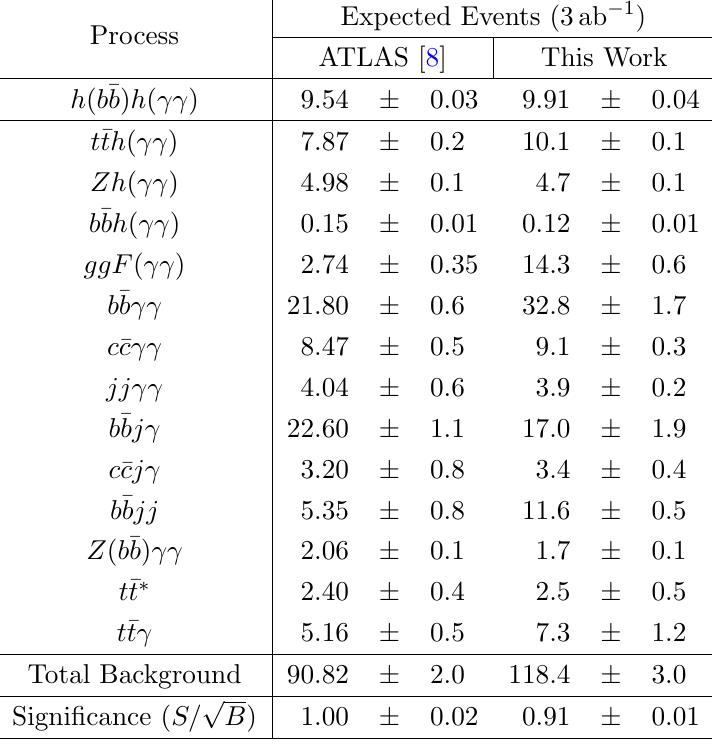
Table 6. Comparison of the expected number of events from each signal/background process at 14 TeV with 3 ab (cid:0) 1 integrated luminosity from the ATLAS HL-LHC projections in [8] and this work, after imposing the selection criteria summarized in appendix A. For the ATLAS expectations, we’ve combined the events categorized as \barrel-barrel" and \other", which is consistent with our criteria. Also shown are the total background and signi(cid:12)cance (computed as S= p B ) from each study.